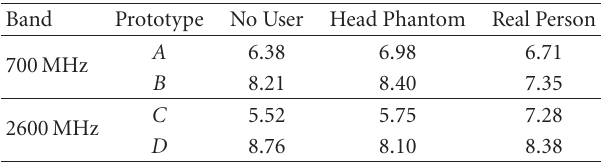
Table 1: Correlation results (mean).